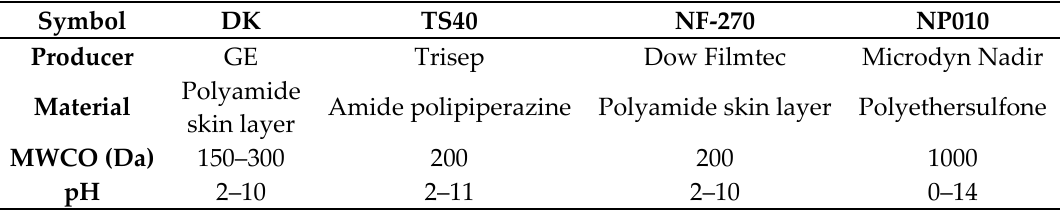
Table 2. Characteristics of nanofiltration membranes (producer’s